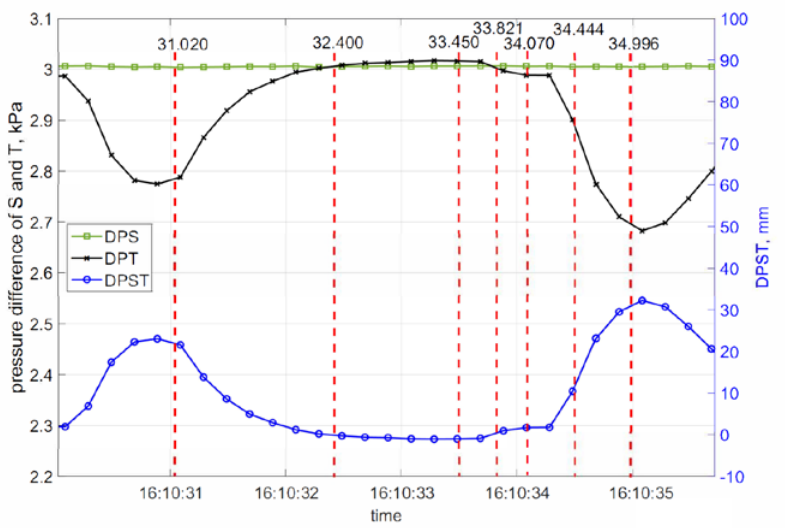
Figure 16. DPS, DPT, and DPST vs. time in one cycle .